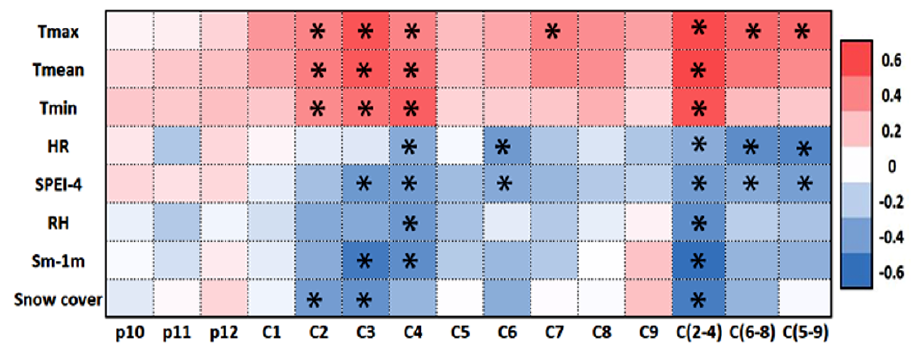
Figure 5. Correlation matrix between the δ 18 O TRC series and various climatic variables (Tmax = max- imum temperature; Tmean = Mean Temperature; Tmin = Minimum Temperature; HR = Homogenous Rainfall; SPEI 04 = Standardised Precipitation-Evapotranspiration Index; RH = Relative Humidity and S m–1 m = soil moisture (0–1 m)). Asterisks indicate p < 0.01% confidence levels. p10–C9 = previous year October to current year September (taking January =